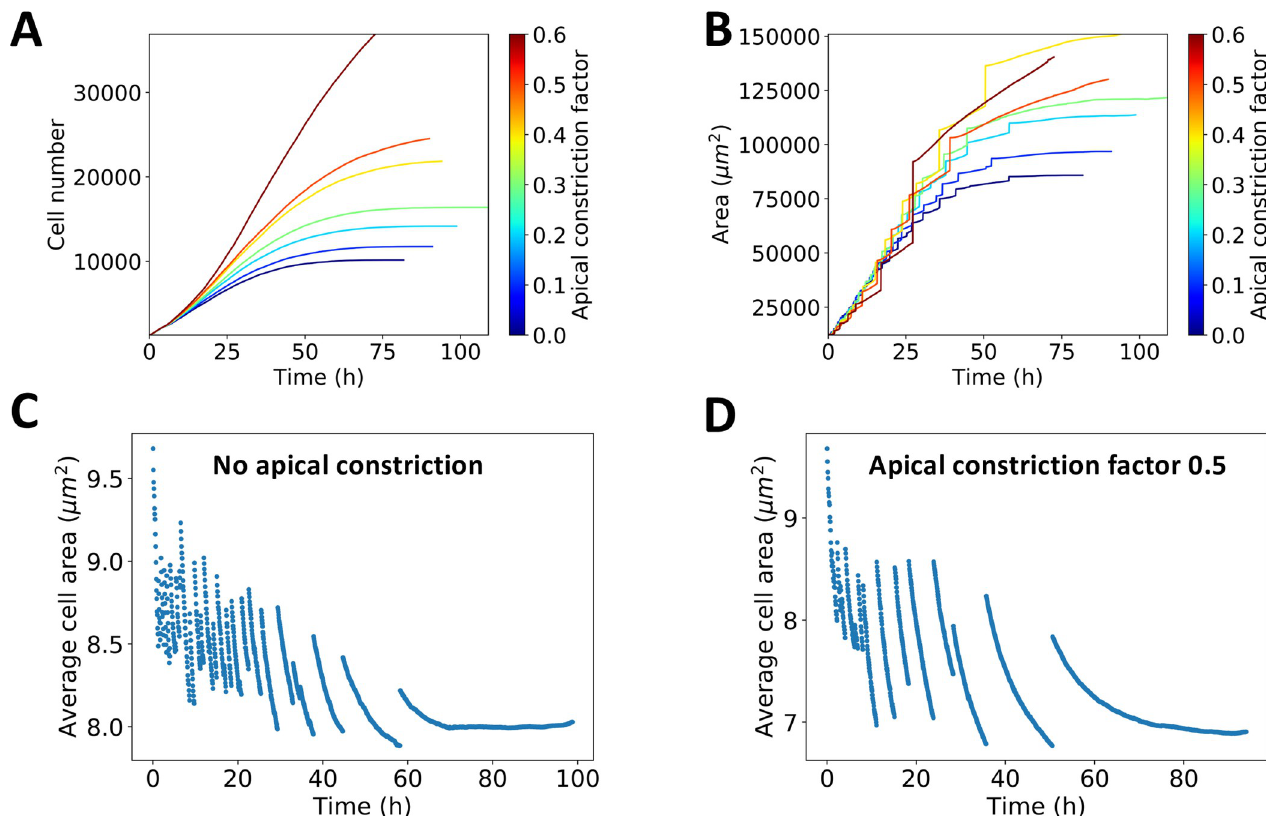
Fig 10. Avalanches depend on the magnitude of apical constriction in the MF. A: Time dependence of the cell number. The larger the apical constriction, the higher the cell number. B: Time dependence of the tissue area for different constriction strengths. The larger the apical constriction, the bigger the tissue area. C-D: Average area for no constriction and moderate constriction. The case of no apical constriction corresponds to more frequent avalanches that take place in higher densities. This highlights the observation that apical constriction in the MF makes avalanches harder to achieve and leads to higher cell